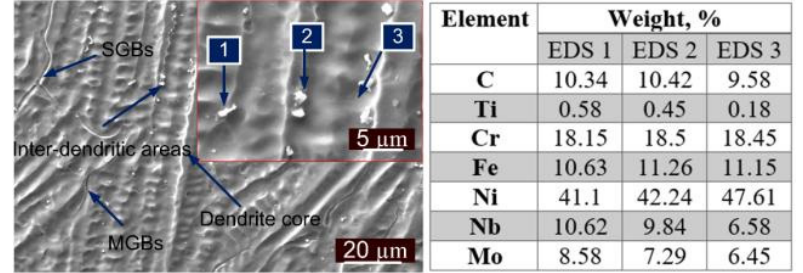
Figure 10. Weld metal near the interface and EDS spectrum corresponding to the marked point.